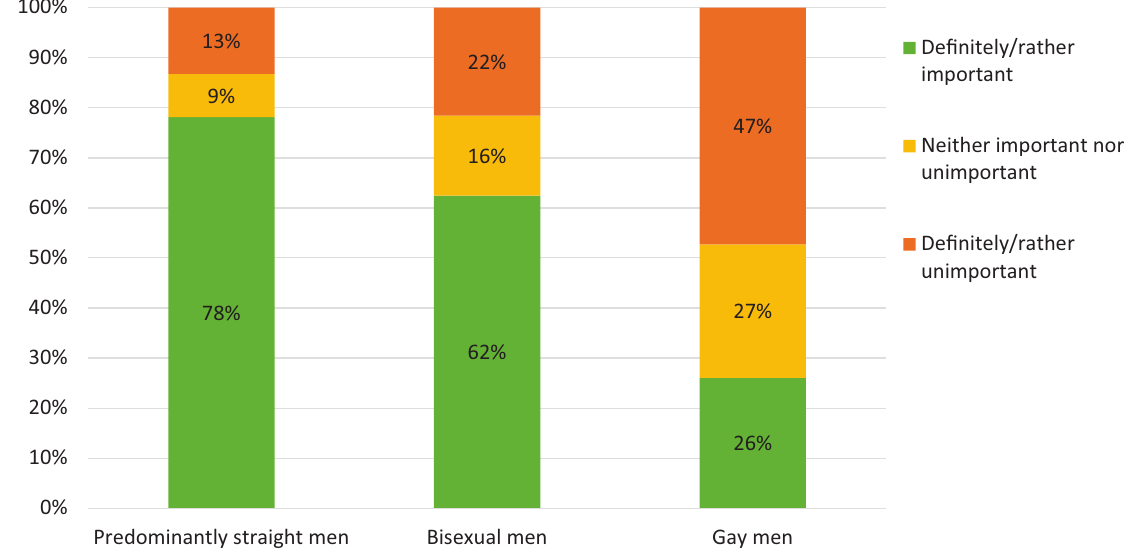
Figure 1. Importance of having one’s own family and raising children, by men’s sexual identities. Note: Chi‐square test is statistically significant (Sig. =